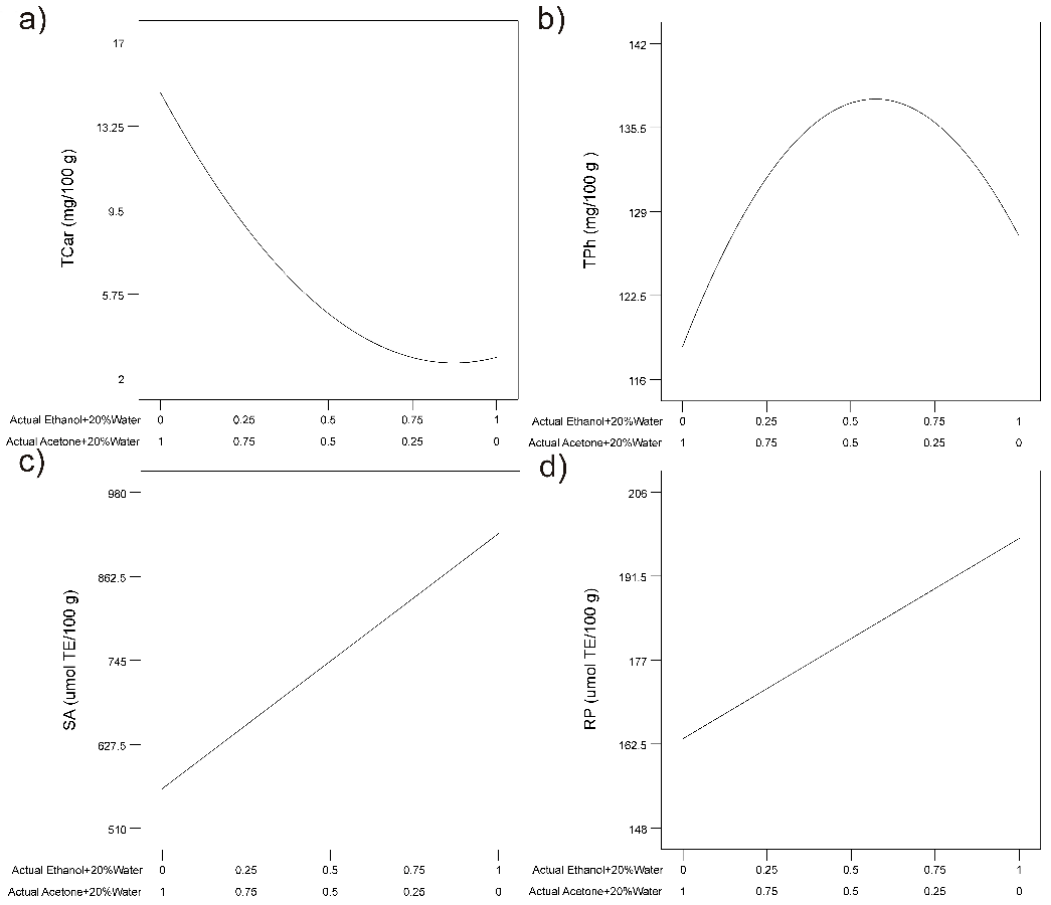
Figure 1. Total carotenoid ( a ) and polyphenol contents ( b ), scavenging activity ( c ), and reducing power ( d ) in ASE extracts obtained with acetone/ethanol mixtures with 20% of water.